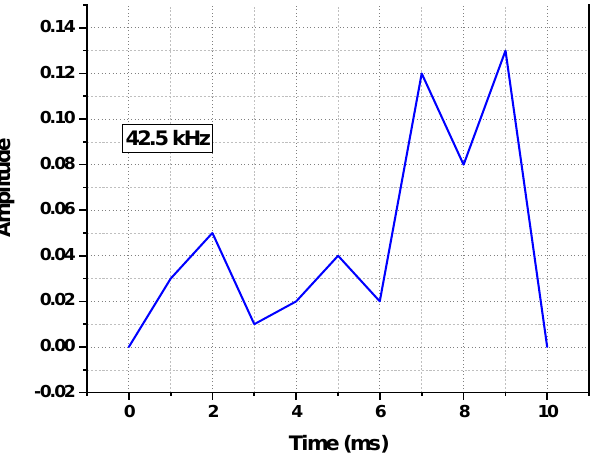
Figure 8. Amplitude vibration traces at different instants in time and 42.5 kHz frequency.